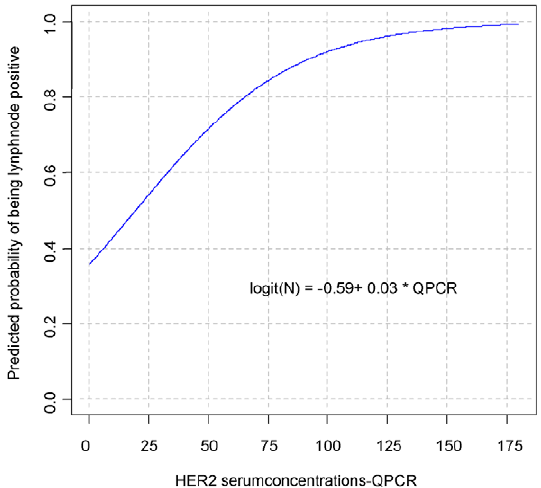
Fig. 5. Logistic regression of lymph node status in terms of HER2 blood mRNA copy number detected by QPCR. The increase in mRNA copy number in the blood is associated with a higher proba- bility to have a positive lymph node status. β -actin and GAPDH) [6]. Quantification of HER2